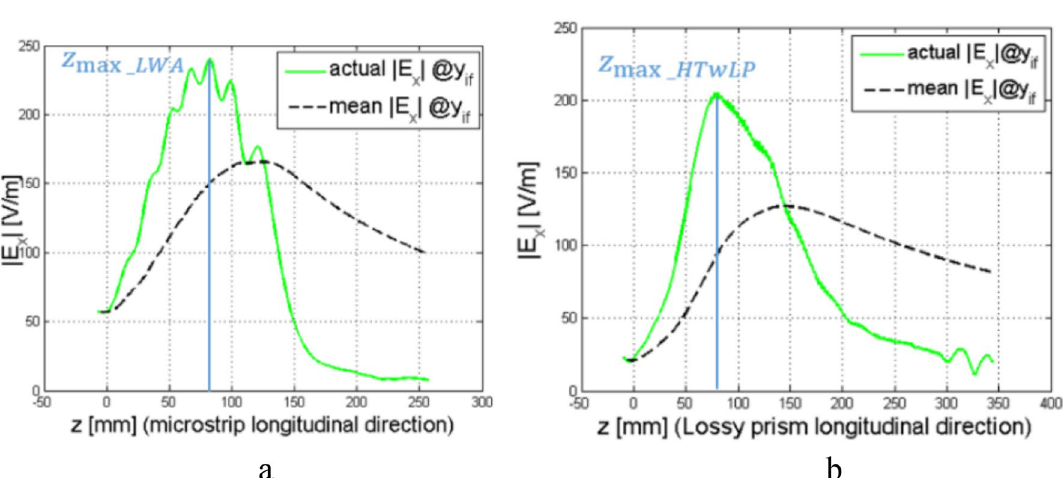
Figure 6. Amplitude of the electric field at the separation interface placed at the distance 1.5 (cid:31) from the antenna aperture, the actual field value ( E x ) is shown in green, while the averaged value is shown in black: ( a ) for the LWA and ( b ) for the HTwLP. In blue, the z max at which the maximum value of the actual field is indicated in both